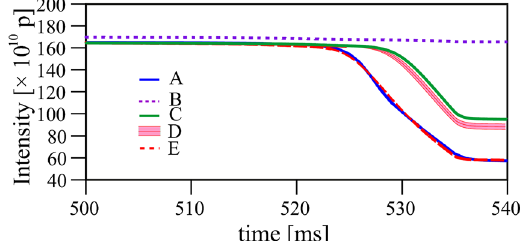
FIG. 18. The dynamic approach to Q y ¼ 4 : intensities vs time without COD correction. Legend: (A) Measurements; (B) Simu- lation without space charge; (C) Simulation with direct space charge; (D) Simulations error bar with direct space charge and random quadrupolar field errors distributions; (E) Simulation with measured quadrupolar fields errors and direct space charge.